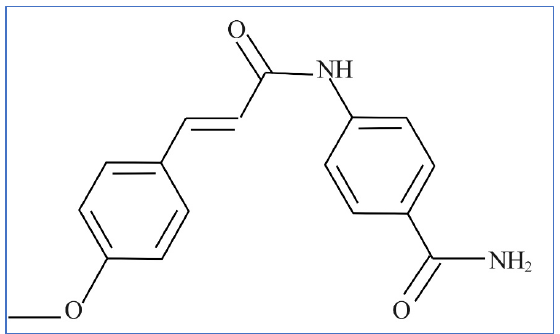
Figure 7. Structure of the direct yellow 24 dye.